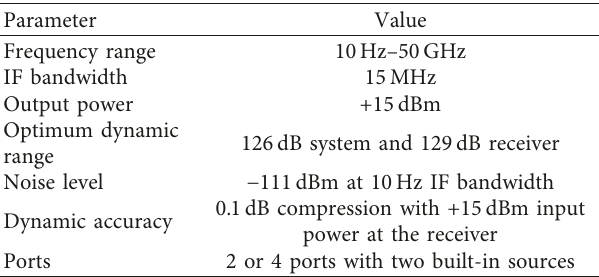
Figure 3: A simplified block diagram of the ground-based Table 1: Specifications of a vector network analyzer.